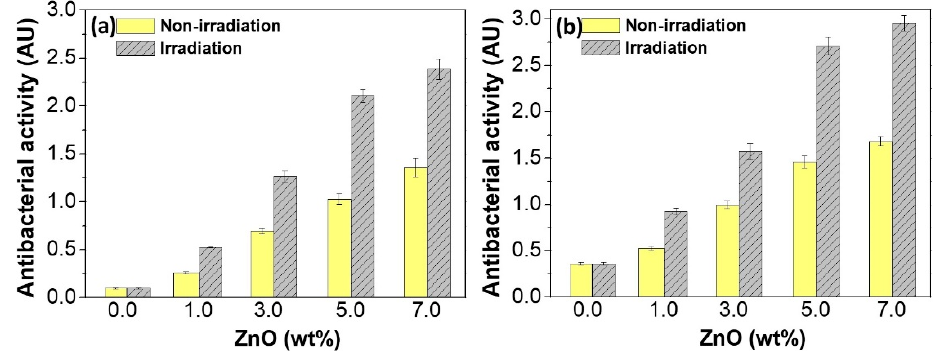
Figure 10. Antibacterial activity of ESO/ZnO nanocomposites against ( a ) E. coli and ( b ) S. aureus . Solid and dashed bars as indicated in Figure 9. Reprinted from [17], copyright 2014, with permission from the American Chemical Society.